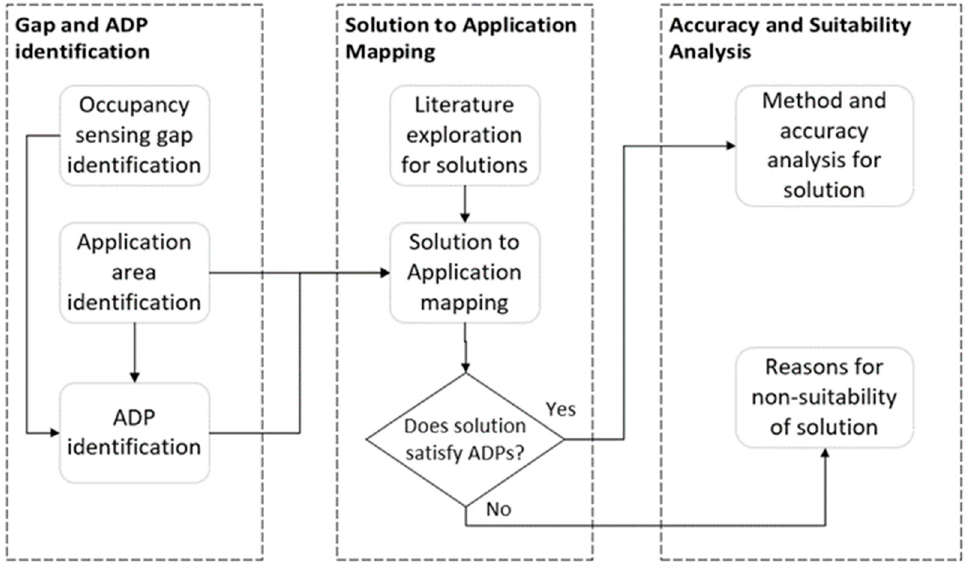
Figure 2. A phased methodology chart outlines the review strategy. First, occupancy sensing gaps that require networked occupancy sensors and corresponding estimation techniques are identified. ADPs for the application area are identified. Solutions from the literature are explored and an analysis is performed to see whether the solutions are suited to the claimed application area.